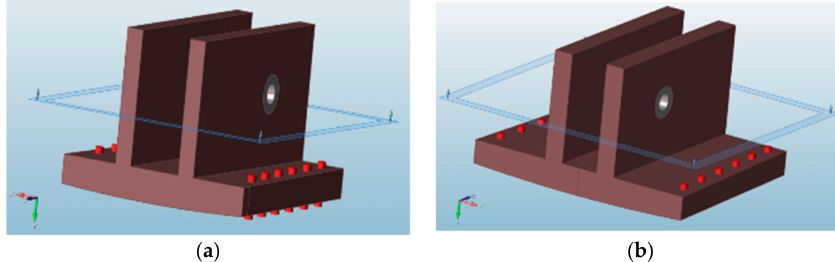
Figure 9. Supports’ original design: ( a ) upper support; ( b ) lower support.